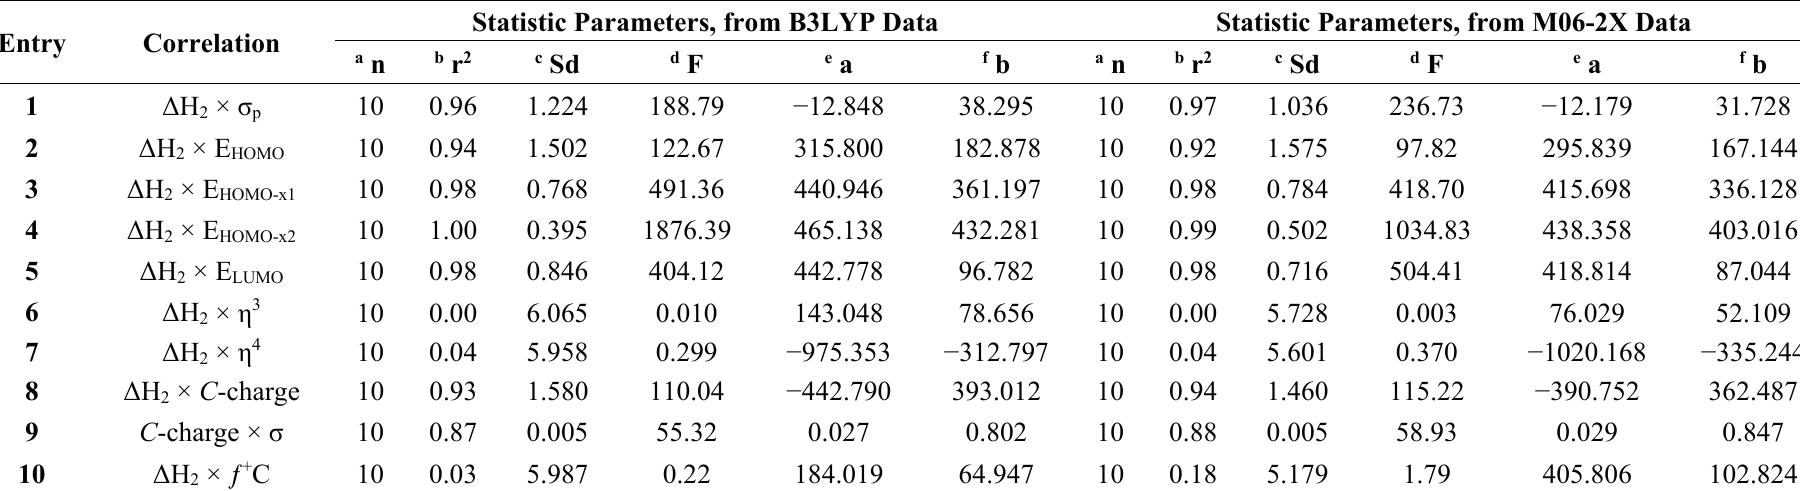
Table 4. Correlations analysis between local properties and enthalpy variation for the protonated 4- or 3-X-cinnamic acid reactions (Step 2), obtained from B3LYP and M06-2X